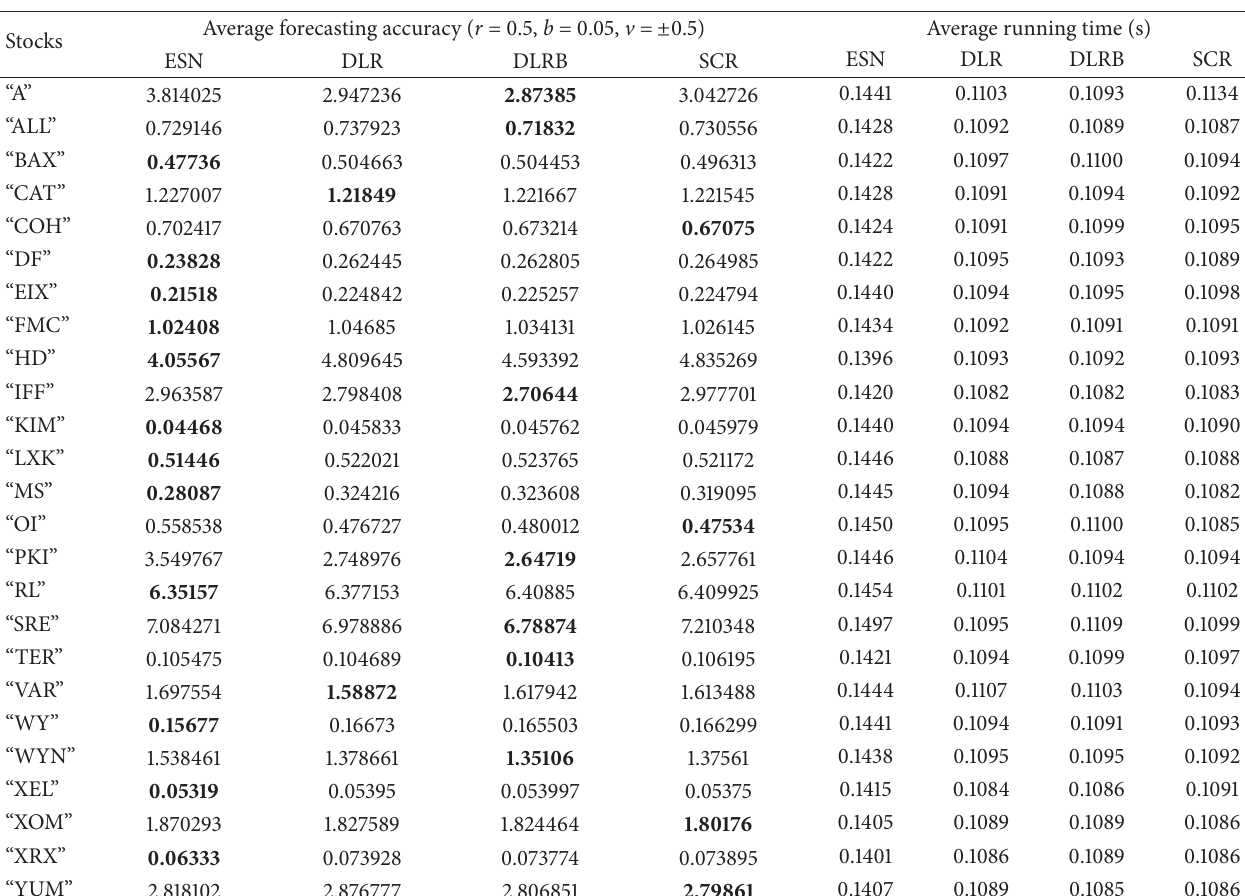
Table 5: Comparisons of average forecasting accuracy (MSE) and running time